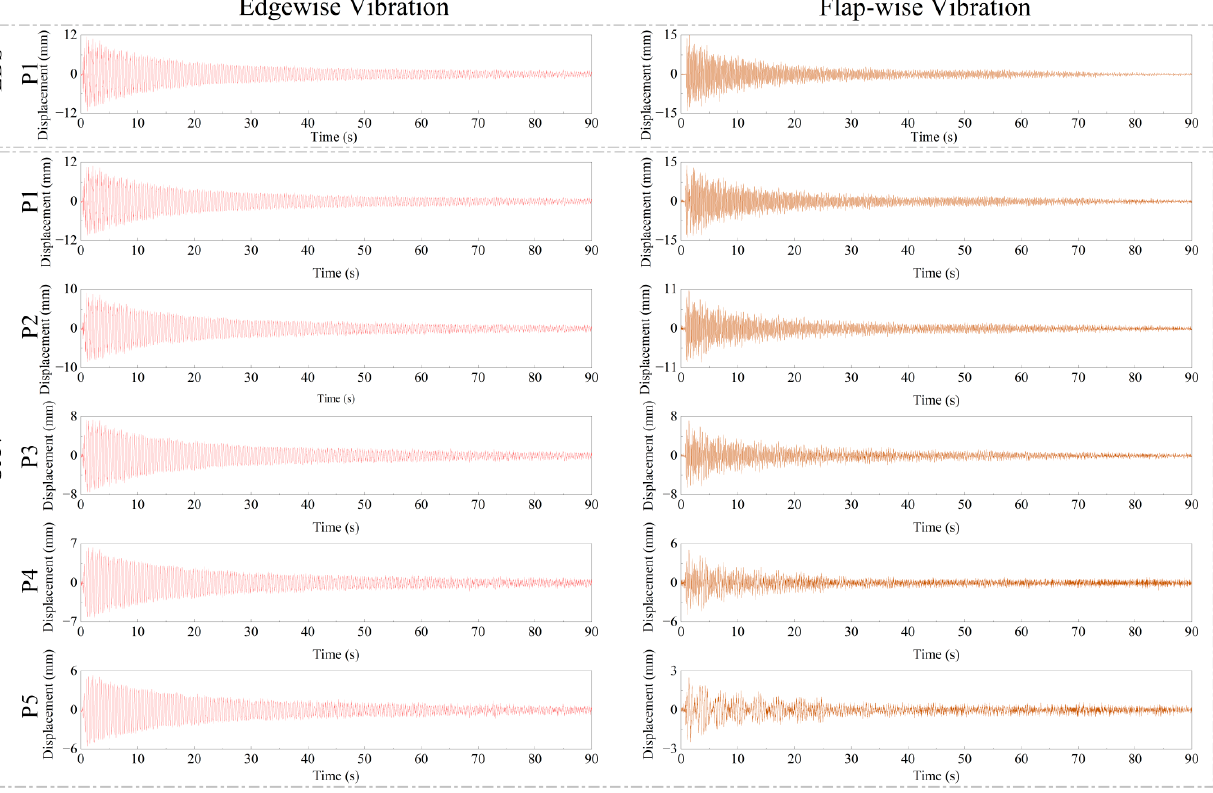
Figure 23. Comparison between vision multipoint monitoring and LDS displacement time history.